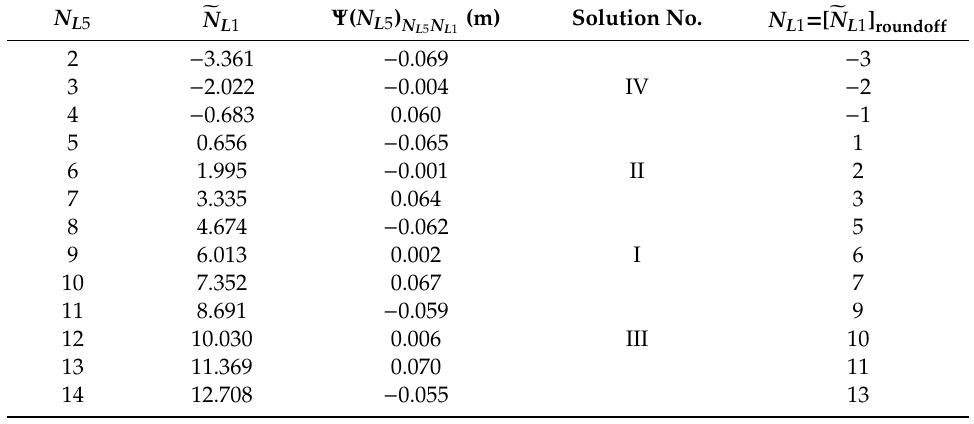
Table 3. Set of integer candidates based on the function Ψ ( N L 5 )